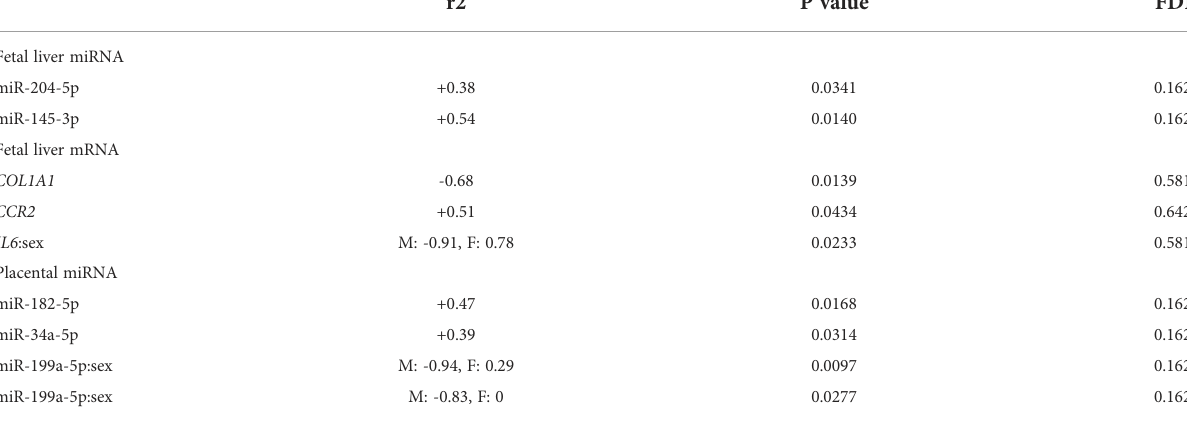
TABLE 3 Fetal liver triglyceride associations with miRNAs and